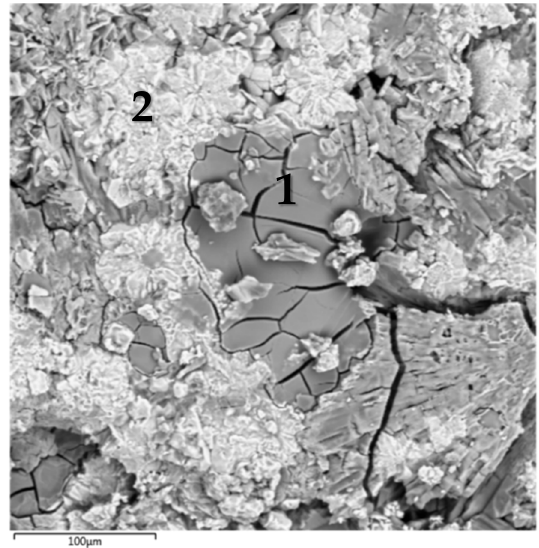
Figure 2. SEM image of the compound containing CsCl. Table 1. Average data of elemental composition of the compound containing CsCl.